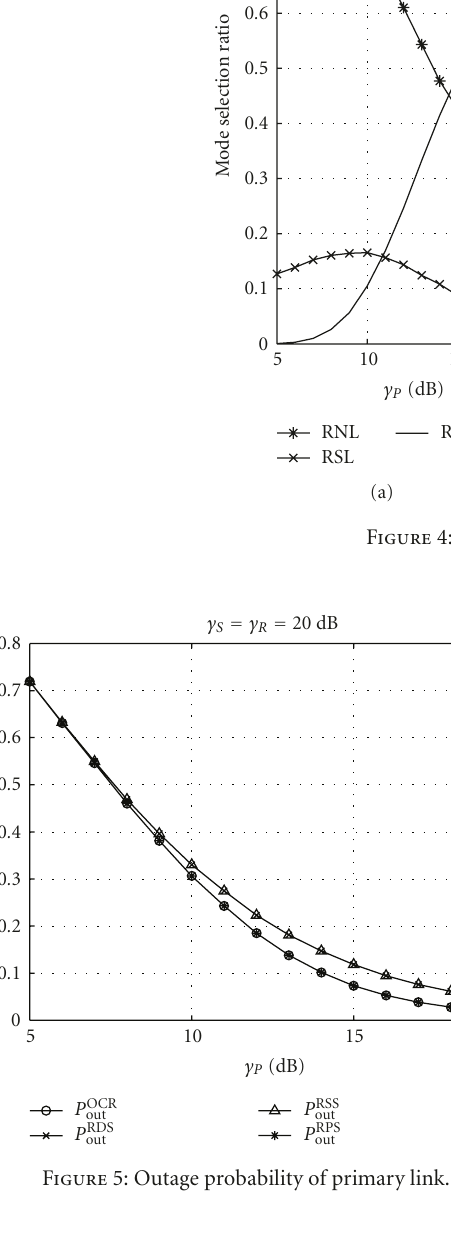
Q pp ( R req ) < 0 and the e ff ective relay condition is